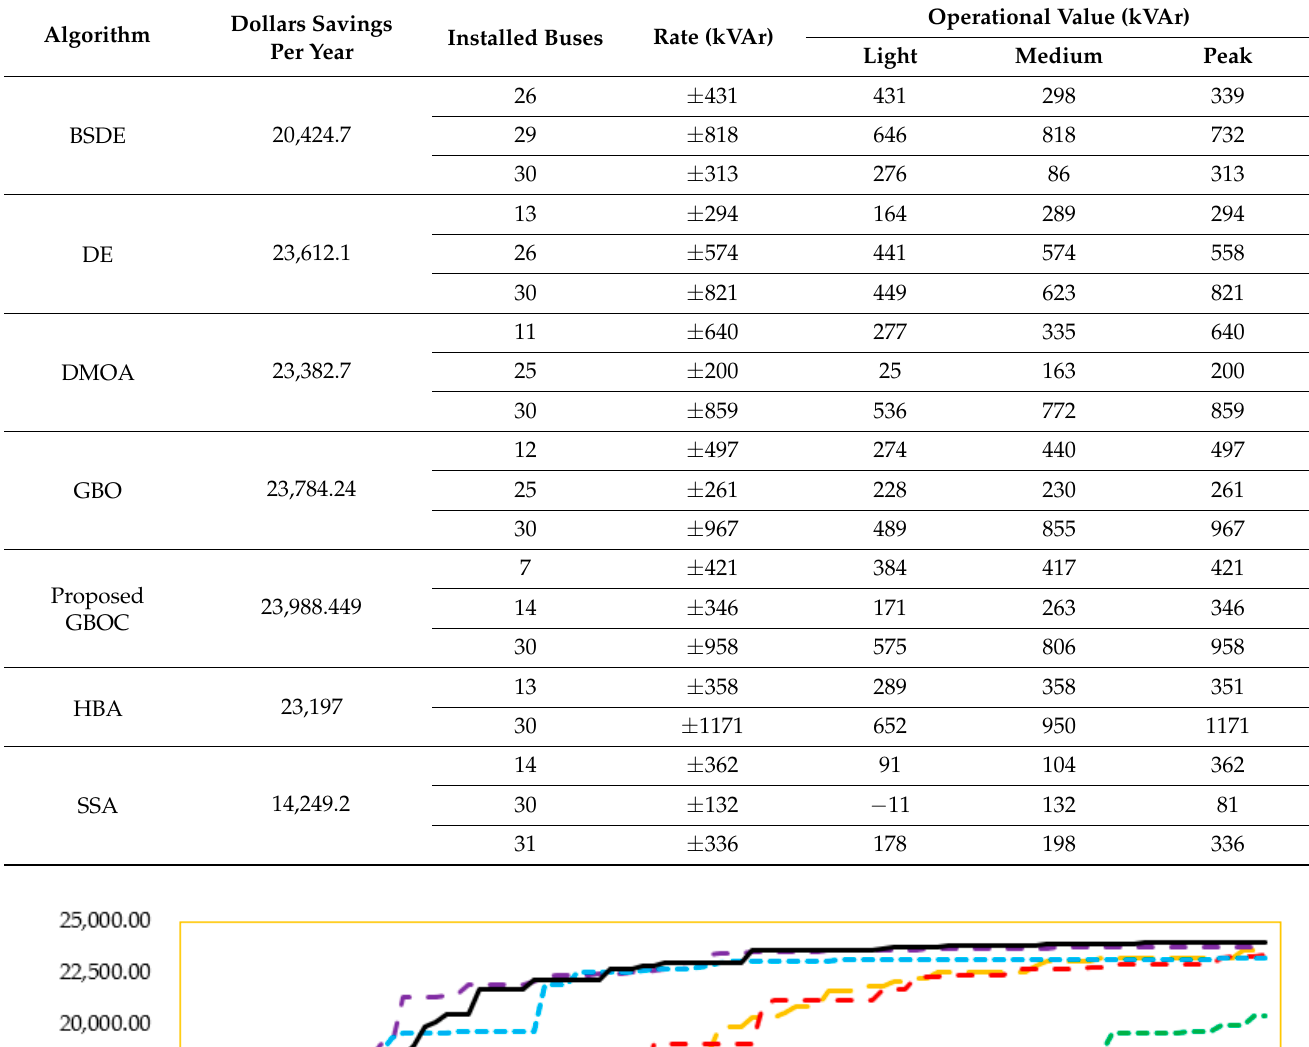
Table 2. Placement and sizing of D-SVC devices for the IEEE 33-distribution system for Scenario 2.